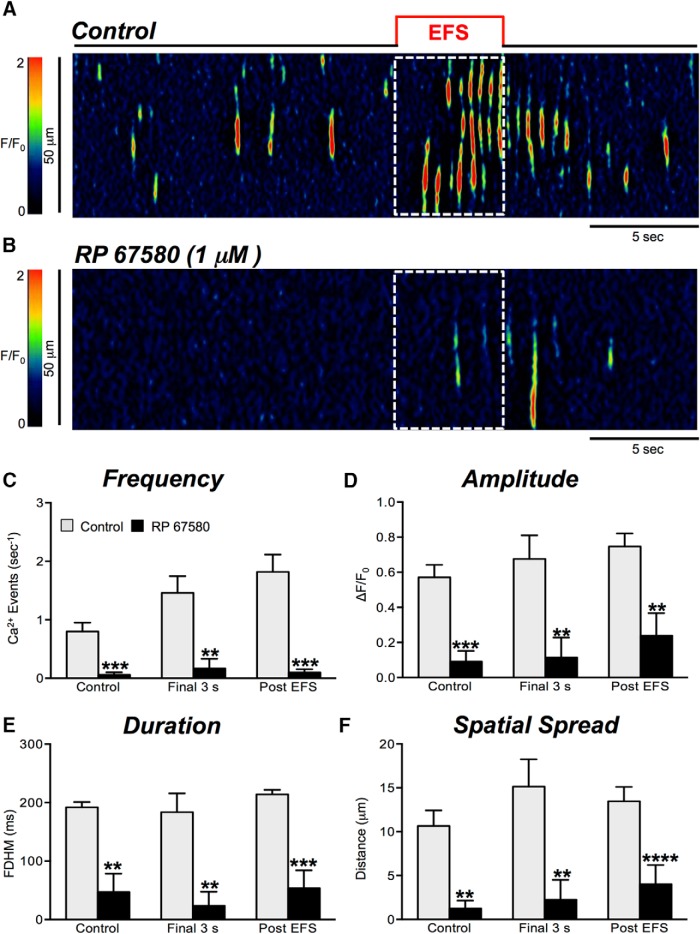
Effects of NK1 receptor antagonist on Ca2+ transient responses to EFS. A, B, Representative ST maps showing the inhibitory effects of NK1 antagonist, RP 67580 (1 μM), on Ca2+ transients in response to nerve stimulation (EFS at 10 Hz for 5 s; indicated by the red line and dotted white box in ST maps). C–F, Summary data showing the inhibitory effects of RP 67580 (1 μM) on Ca2+ transient frequency (C), amplitude (D), duration (E), and spatial spread (F) in ICC-DMP during the control period, during the final 3 s of EFS, and during the post-EFS period (5 s), n = 4, c = 11. Note: RP 67580 reduced all Ca2+ transient parameters significantly; ns = p > 0.05, *p < 0.05, **p < 0.01.